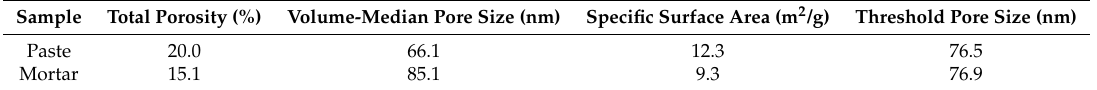
Table 3. Characteristic pore parameters of paste and mortar form